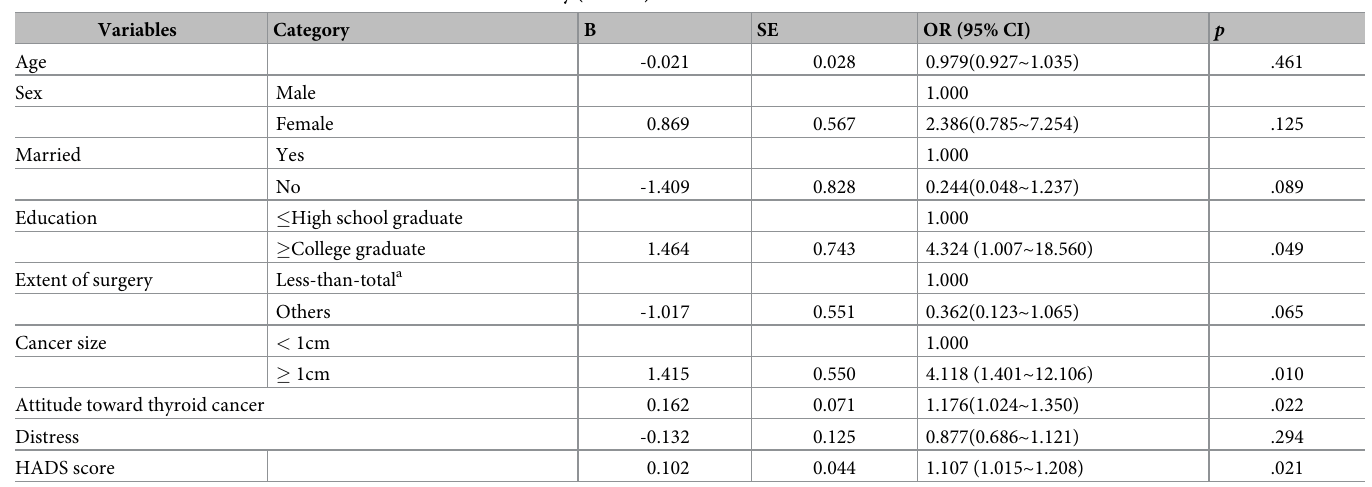
Table 4. Factors associated with use of an online health community (n = 114).